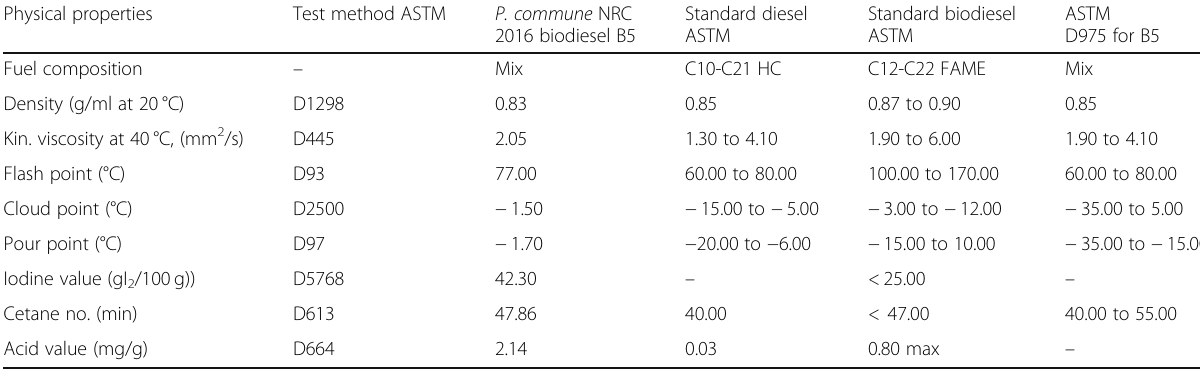
Table 1 Physical properties of biodiesel obtained from blending biodiesel of P. commune NRC2016 as compared with standard diesel ASTM, standard biodiesel ASTM, and ASTM D975 (standard biodiesel for B5) Physical